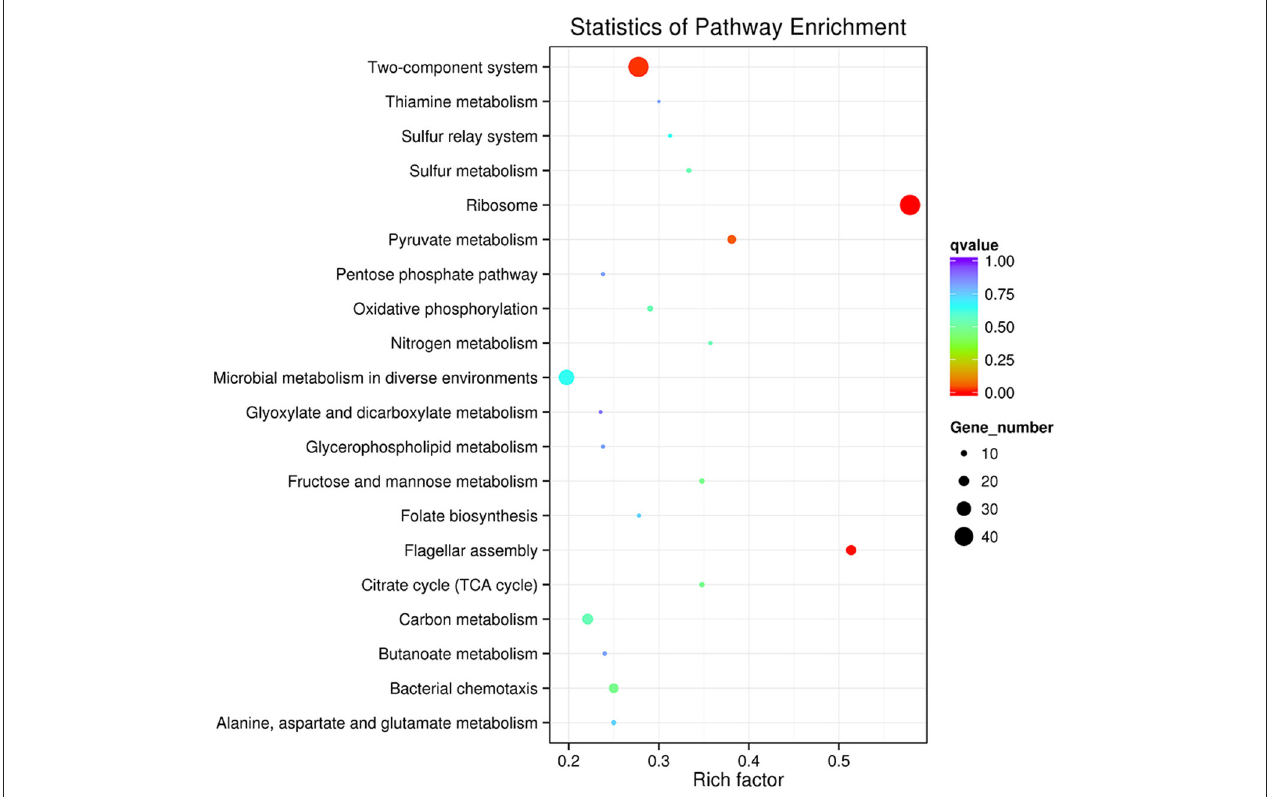
FIGURE 6 | The Top20 pathways with the most significant p -value. The x-axis indicates percentages of DEGs belonging to the corresponding pathway. The left y -axis represents the top 20 pathways. The sizes of the bubbles represent the number of DEGs in the corresponding pathway, and the colors of the bubbles represent the enrichment p -value of the corresponding pathway. KEGG terms with P -value < 0.05 were considered significantly enriched by differential expressed genes.